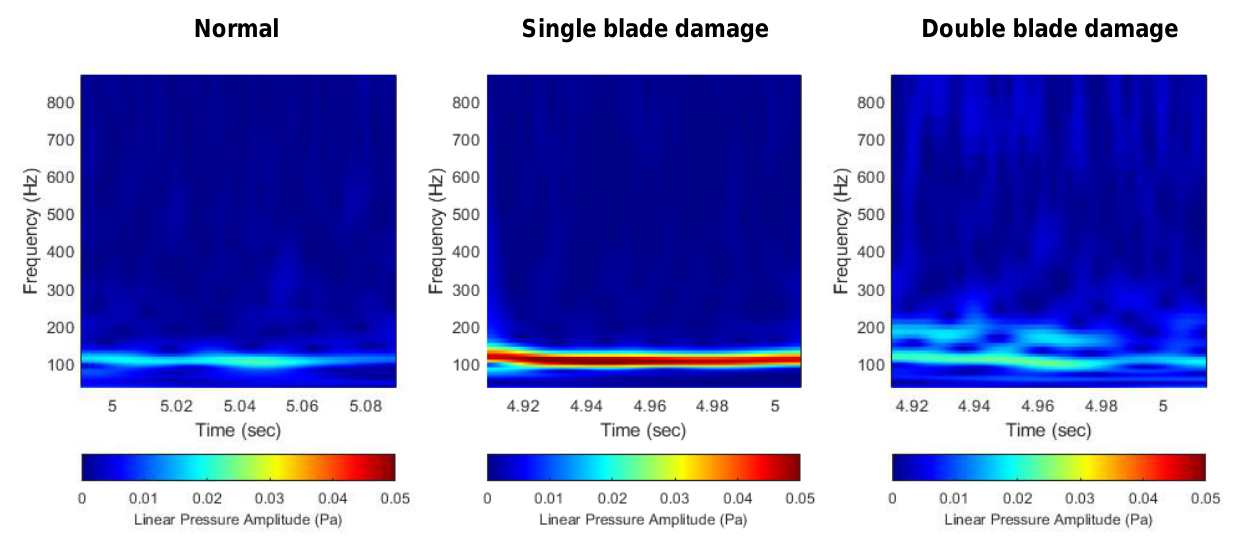
Figure 10. Comparison of flow noise scalogram with linear scale. ( left ) Normal, ( middle ) single-blade damage, ( right ) double-blade damage.